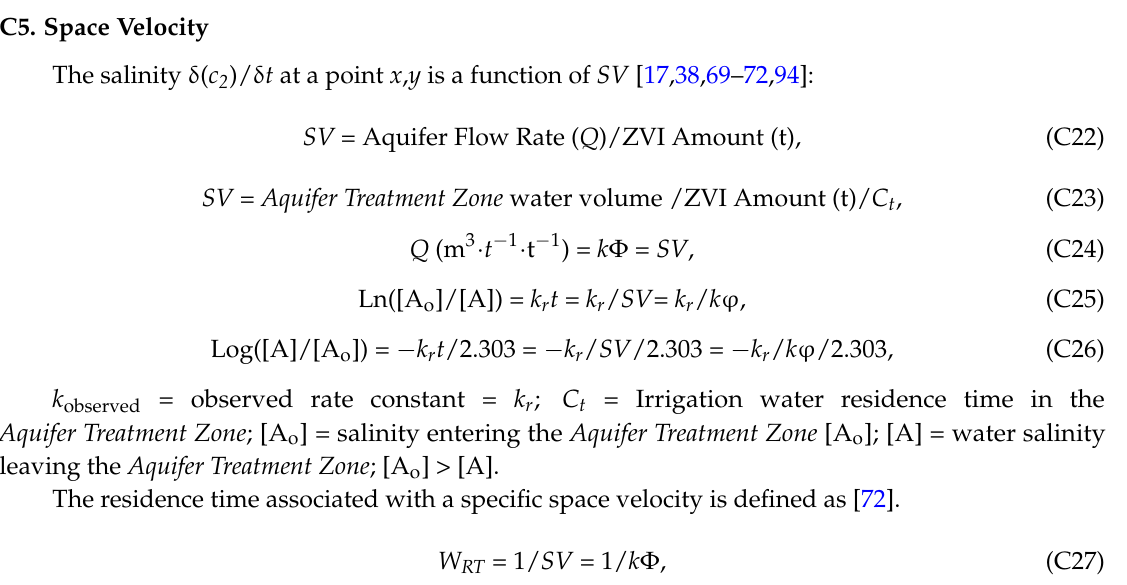
Figure C7. ST ZVI desalination pellets [16]; Type A Catalyst: Indicative Eh and pH of the irrigation water, maximum pH/minimum Eh in the aquifer as a function of P w . ( a ) pH vs. P w ; ( b ) Eh vs. P w ; ( c ) Eh vs. pH. Data Source: Desalination Pellet Trials ST1a to ST5j [16]. Feed water pH = 5.8–6.6. C6.2. Estimating Permeability Changes Due to Mineral Precipitation and Gas Occlusion Extending Equation (C6), to address decreases in porosity due to mineral precipitation results in: k (t = n) = k 0 · S p n2 ,